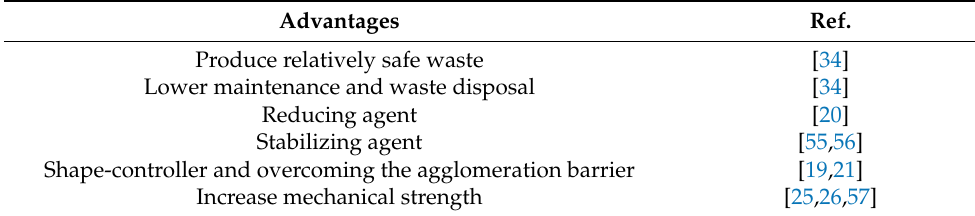
Table 2. The advantages of HA synthesis using natural materials.